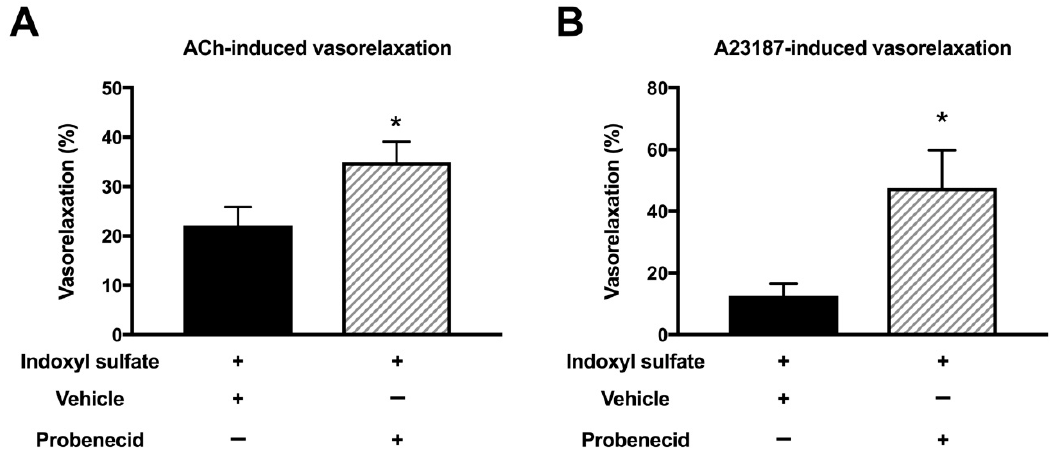
Figure 7. Effect of organic acid transporter inhibitor on vasorelaxations induced by 3 × 10 − 7 mol/L acetylcholine (ACh) ( A ) or 10 − 7 mol/L A23187 ( B ) in the aorta treated with indoxyl sulfate. Probenecid (10 − 3 mol/L) or vehicle (ethanol) was applied for 30 min; thereafter, indoxyl sulfate (10 − 4 mol/L) was incubated for 30 min before phenylephrine (PE) application. The ordinate shows vasorelaxation as a percentage of the PE-induced vasocontraction (0% being defined as the plateau level of precontraction). Data are presented as mean ± standard error of mean (SEM) values from six experiments. * p < 0.05 vs. indoxyl sulfate group.